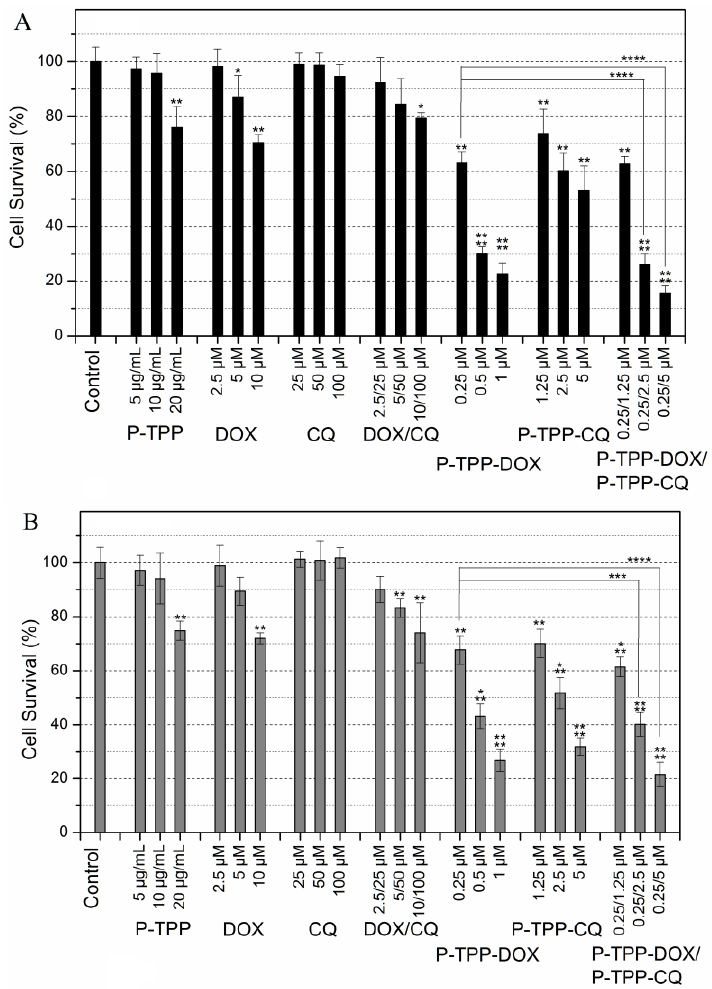
Figure 3. Comparative toxicities of P-TPP (carrier), free DOX, CQ and their combination, as well as of P-TPP-DOX, P-TPP-CQ or their combination on PC3 ( A ) and DU145 cells ( B ) following incubation at various concentrations for 3 h as determined by MTT assays 24 h following incubation. In all P-TPP-DOX experiments, the encapsulated DOX concentration was 0.25, 0.5 or 1 µ M, and the corresponding carrier concentration was 5, 10 and 20 µ g/mL (corresponding to 1.75, 3.5 and 7.0 µ M of P-TPP). The statistical significance, resulting from Student’s paired two-tailed t -tests, follows the assignment: * p < 0.05, ** p < 0.01, *** p < 0.001 and **** p < 0.0001, while no annotation implies no statistical significance, p > 0.05.